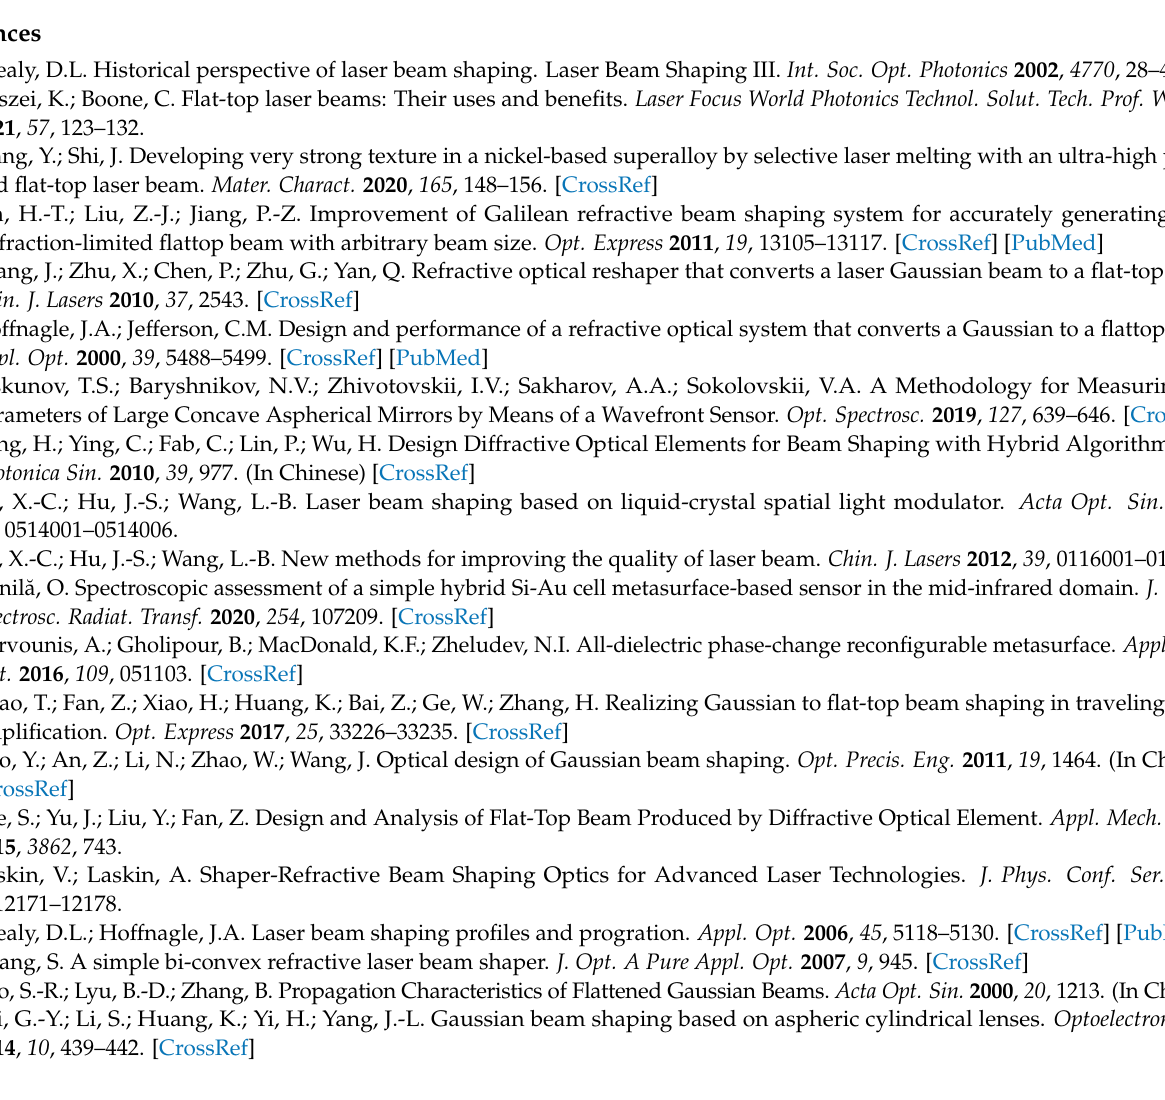
lens 1; Figure S2: Geometrical dimensions of aspherical cylindrical lens 2; Figure S3: Geometrical dimensions of cylindrical lens 3; Figure S4: Geometrical dimensions of cylindrical lens